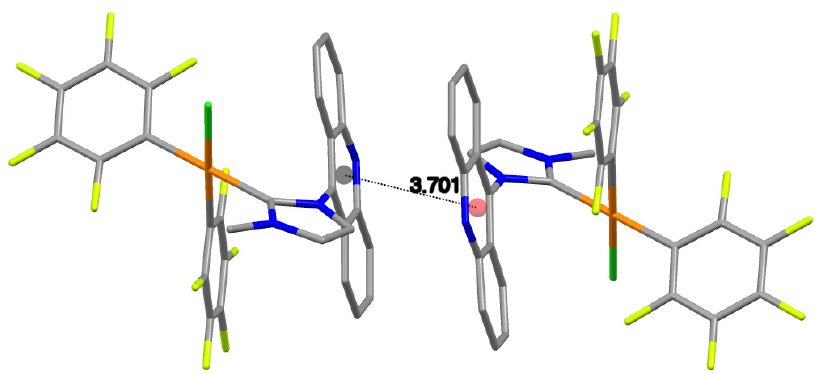
Figure 6. Offset π ··· π stacking interactions of complex 2 .